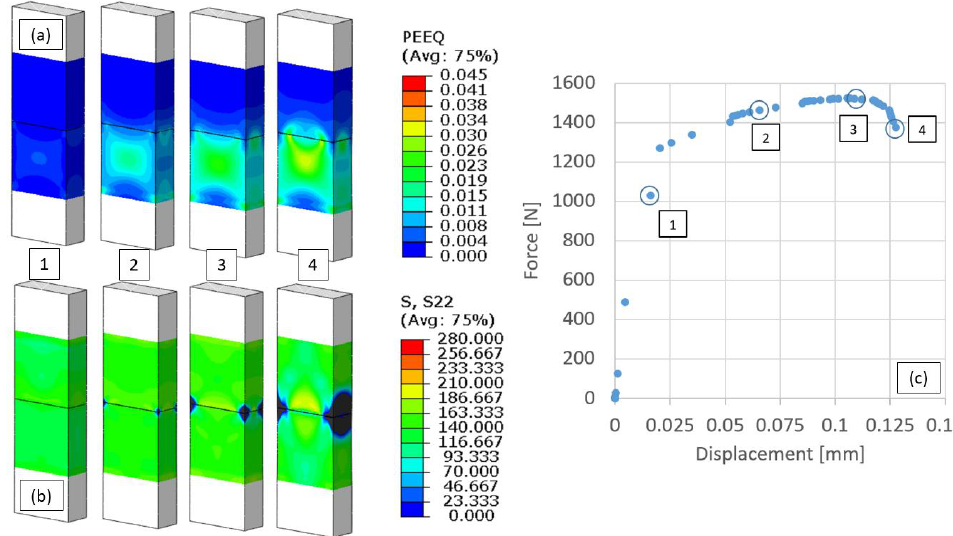
Figure 19. Computed evolution of the equivalent plastic strain ( a ), axial stress component ( b ) and the force displacement curve ( c ) at different stages of the tension test (points 1 – 4).